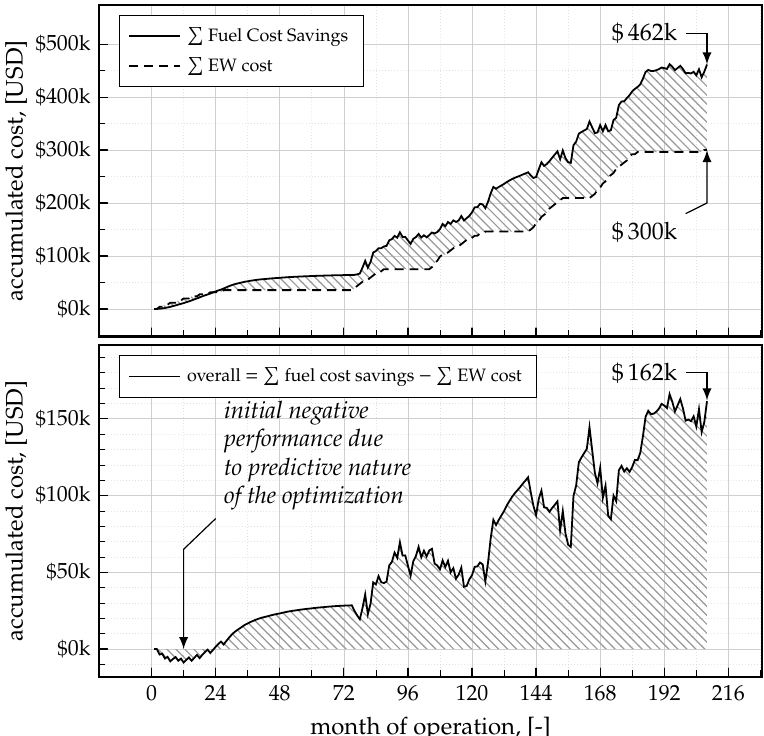
Figure 19. Accumulated fuel cost changes (compared to the reference, ( top )) and accumulated engine wash cost ( bottom